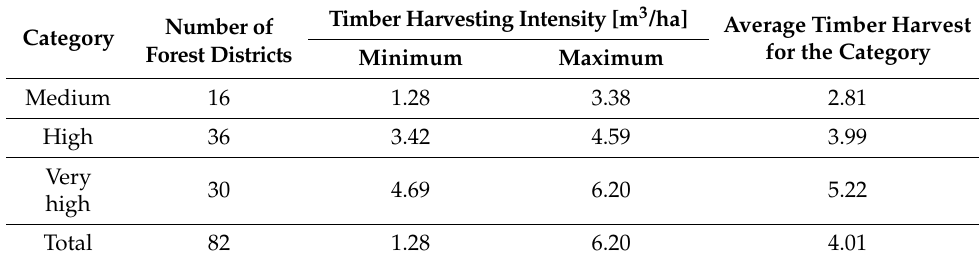
Table A6. Categories distinguished on the basis of timber harvesting intensity (per 1 ha of forest area). Category